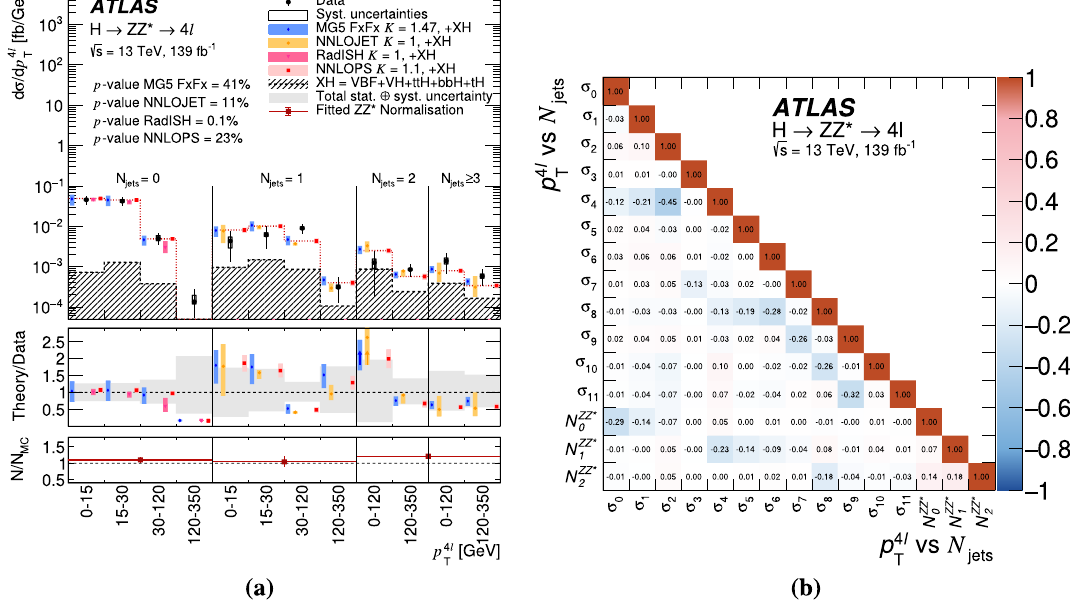
Fig. 34 a Doubledifferentialfiducialcrosssectionsofthe p 4 (cid:3) cross sections and the Z Z ∗ background normalisation factors is shown in b . The p values shown are calculated for all bins across both p 4 (cid:3) N jets